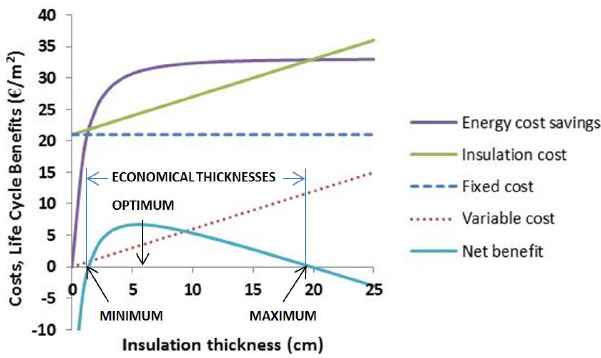
Figure 3. Variation of insulation costs, energy cost savings and accumulated net benefits with insulation thickness.